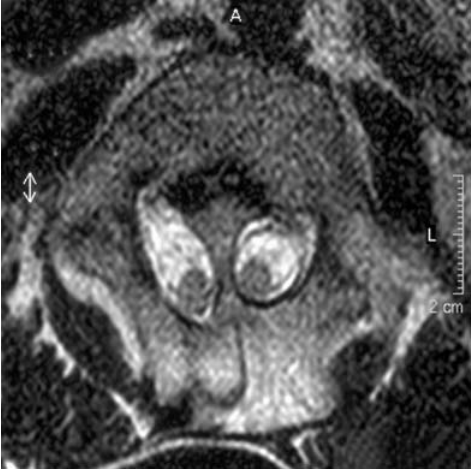
FIGURE 3. Axial T2-weighted fast spin echo image showed bony spur dividing both the dural sac and spinal cord.